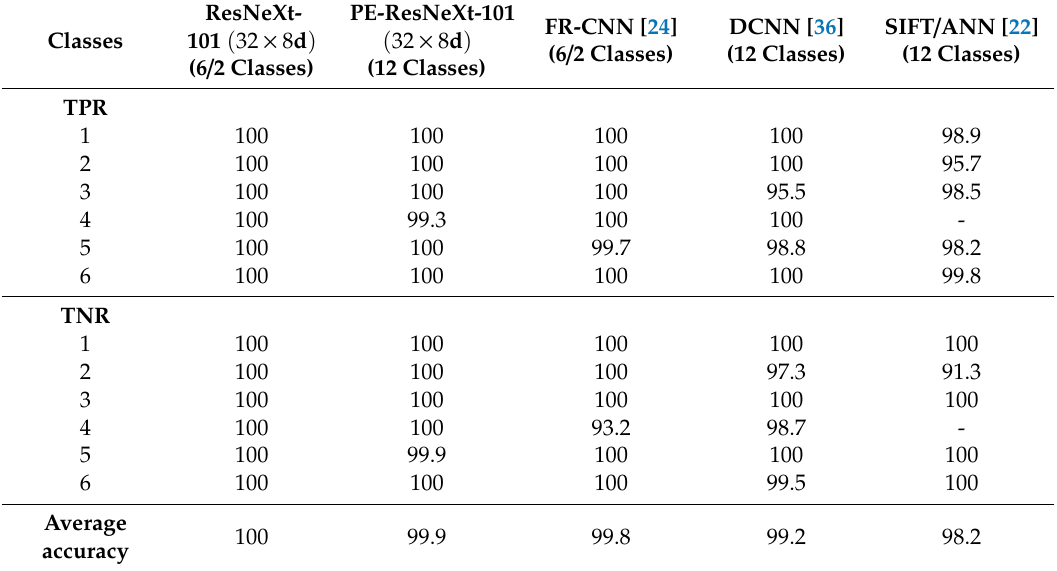
Table 5. Comparison of accuracy (%) of the proposed and previous